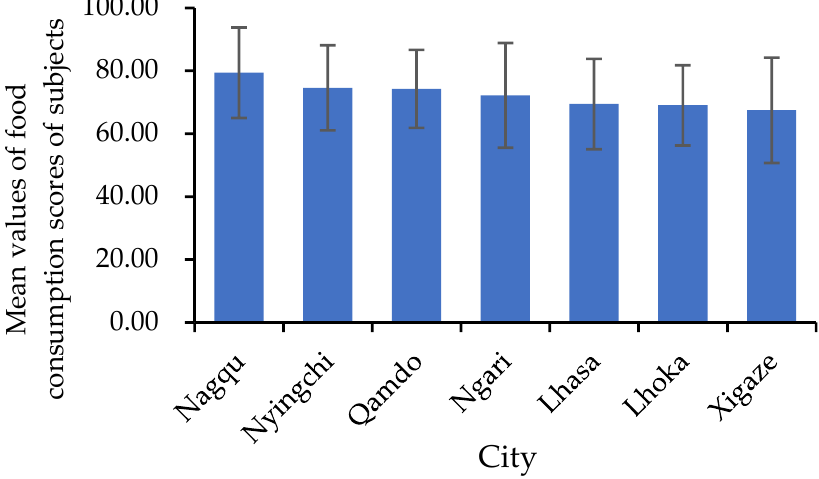
Figure 6. Mean values of food consumption scores of subjects in cities.